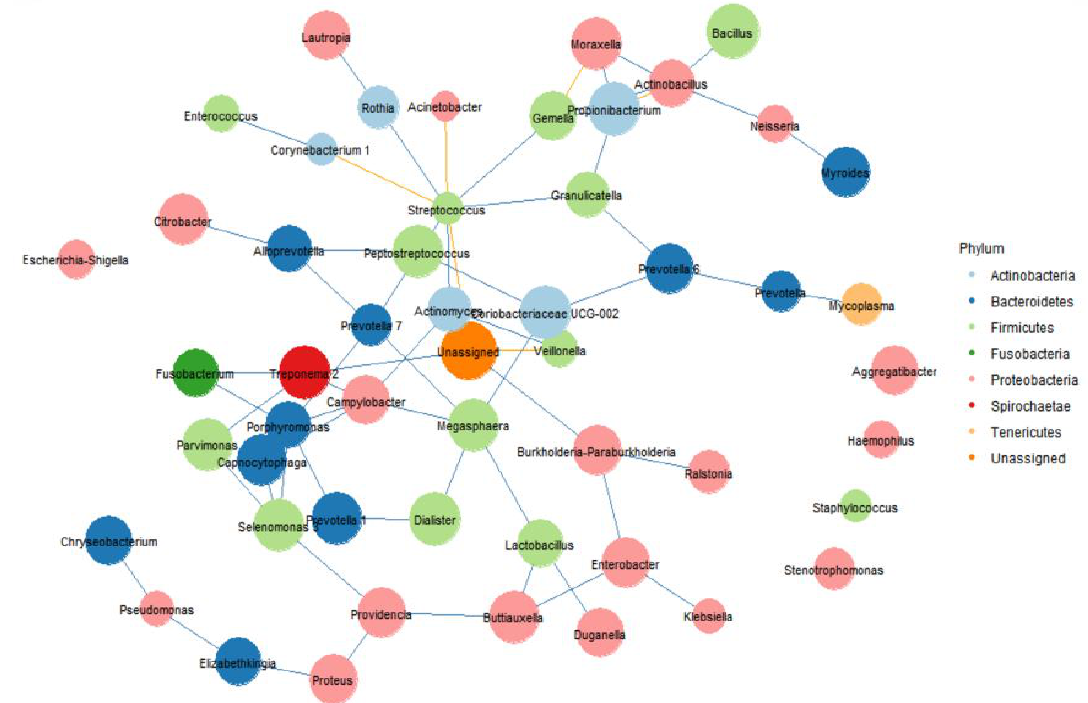
Figure 4. Microbial network of intubated patients with pneumonia, consisting of 53 nodes and 60 edges. Edges show associations with FDR (false-discovery rate) q-values < 0.05 with bidirectionality. Each edge indicates a significant correlation between OTUs; blue, n = 54, positive; yellow, n = 6, negative.